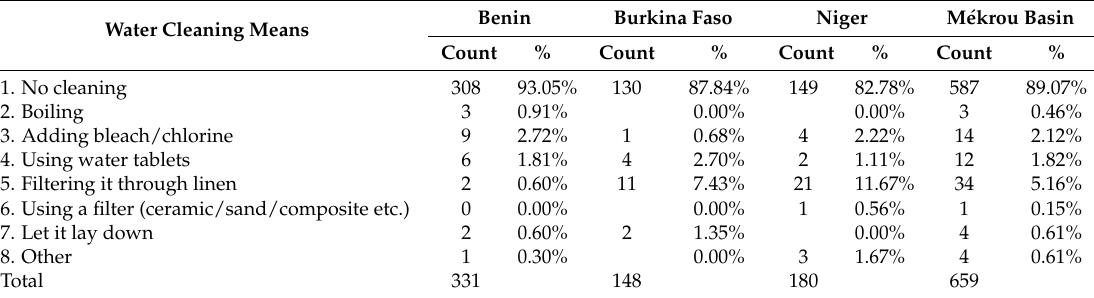
Table 4. Techniques used at the household to improve water quality.